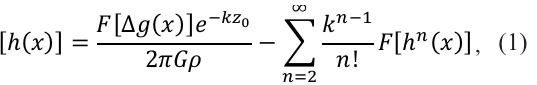
Table 1. Parameters used in Moho